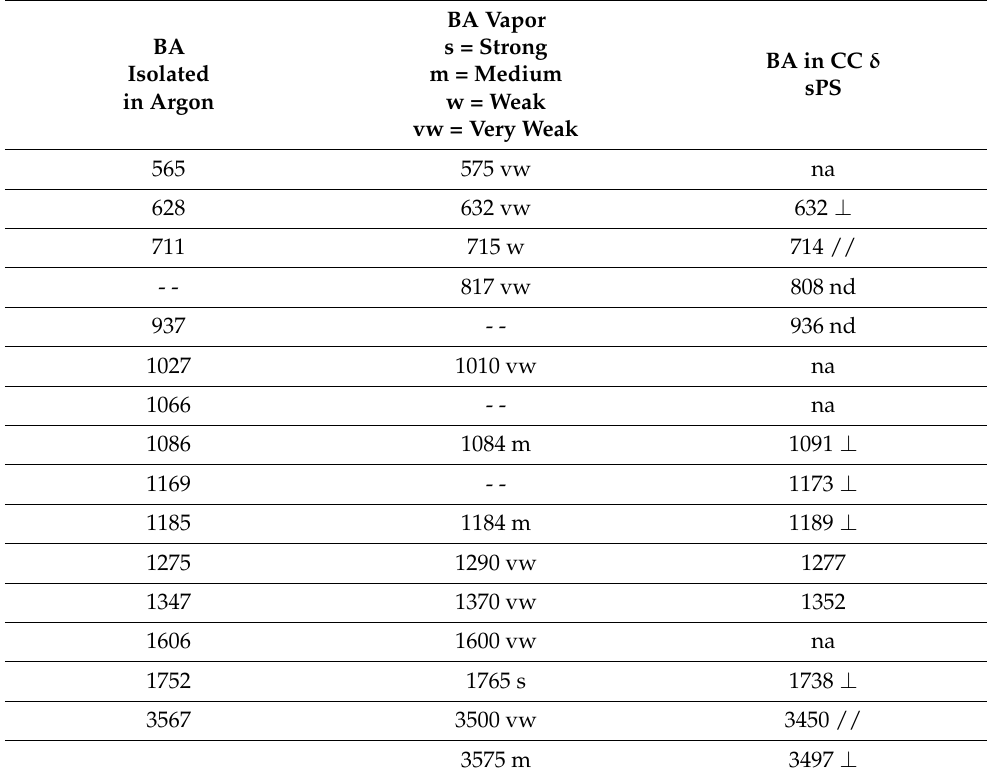
Table 2. FTIR peaks of isolated BA as taken from [37] (in argon matrix), as observed in the vapor phase spectra (at 433 K) [36] and in the axially stretched δ -form sPS film. BA Vapor s = Strong BA BA in CC δ m = Medium Isolated sPS w = Weak in Argon vw = Very Weak 565 575 vw na 628 632 vw 632 ⊥ 711 715 w 714 // - - 817 vw 808 nd 1010 vw na 1066 - - na 1086 1084 m 1091 ⊥ 1169 - - 1173 ⊥ 1185 1184 m 1189